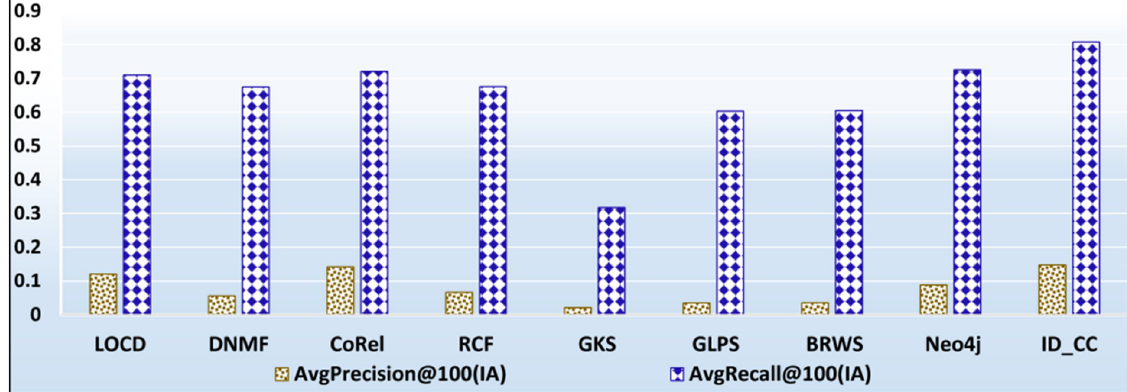
Fig 25. The prediction accuracies of the methods using the setup described in